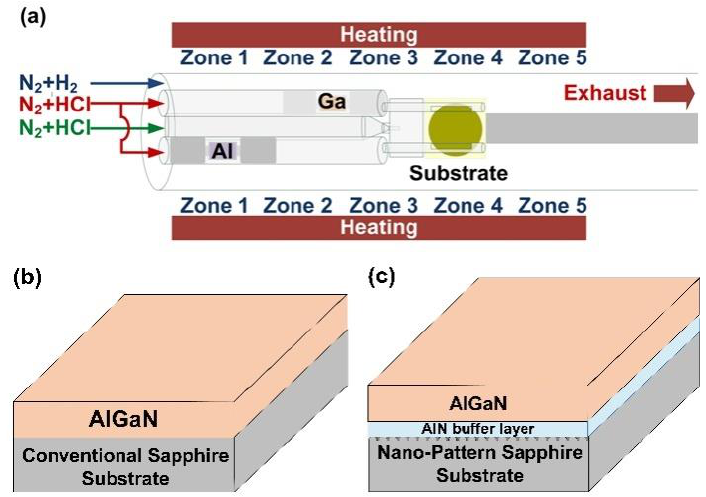
Figure 1. ( a ) A schematic diagram of the HVPE reactor used for the AlGaN grown on the ( b ) CSS and ( c ) AlN/NPSS templates.